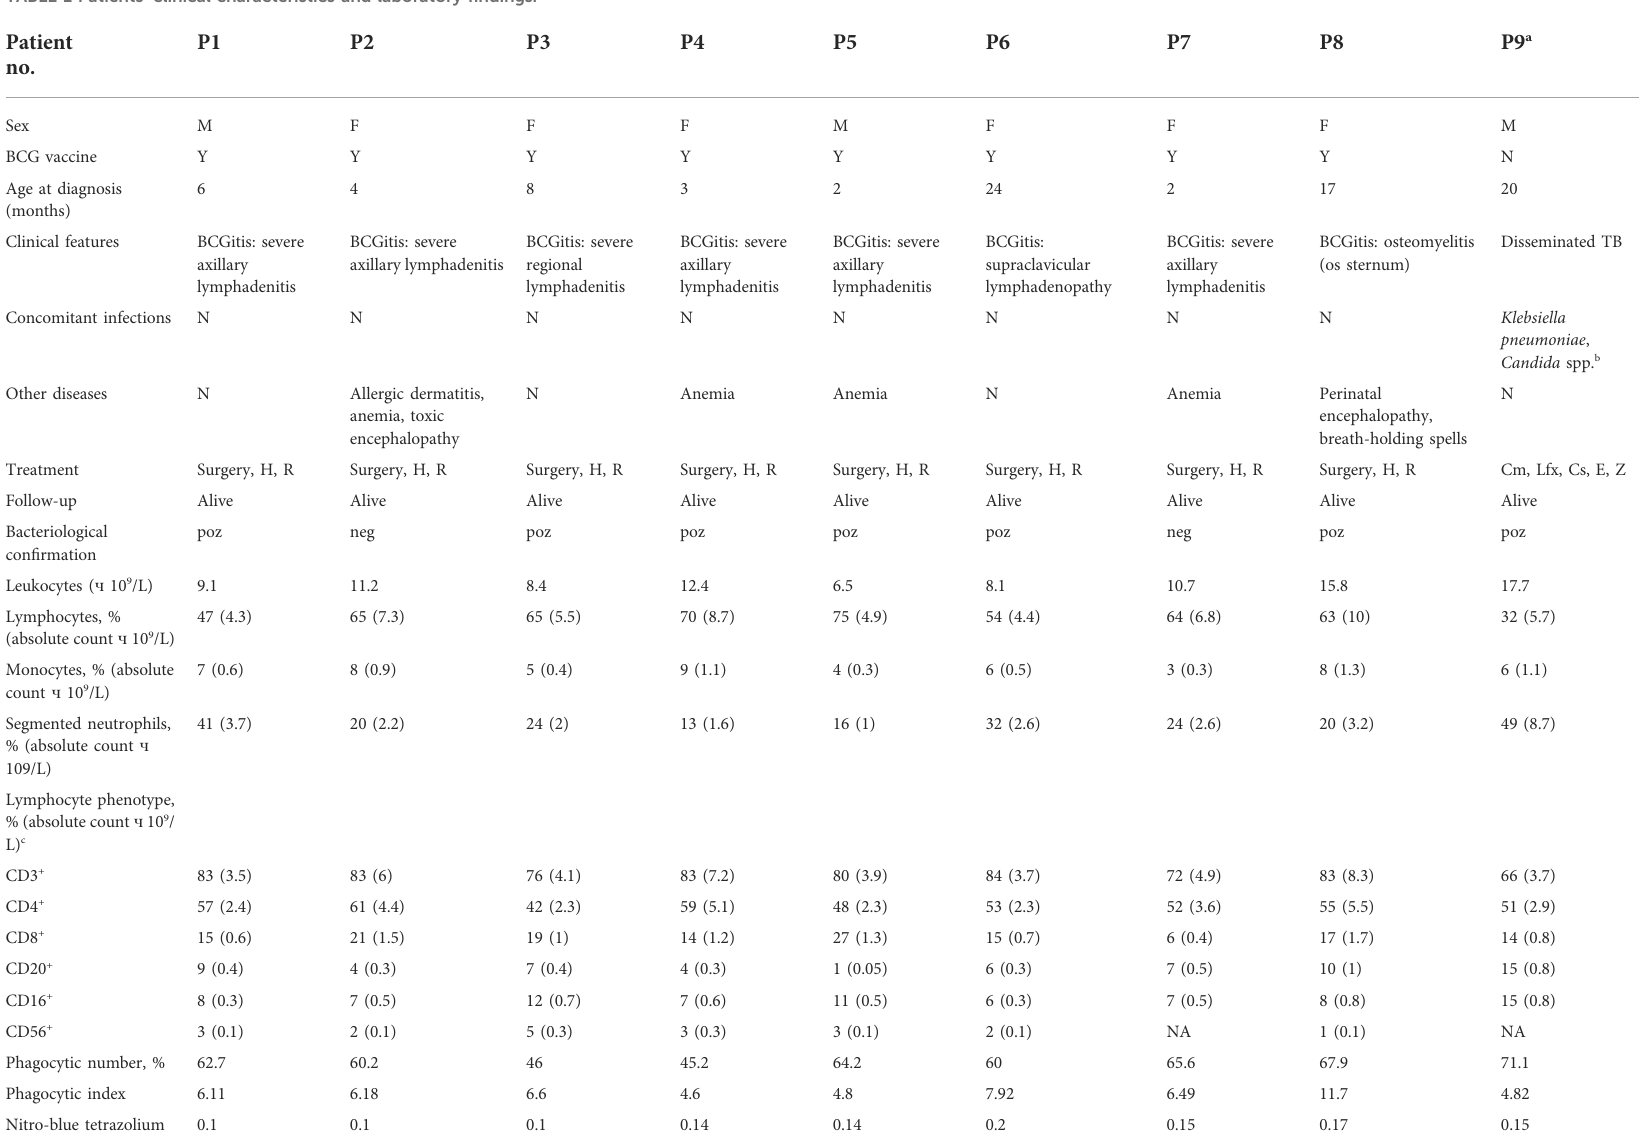
TABLE 1 Patients ’ clinical characteristics and laboratory fi ndings. Patient